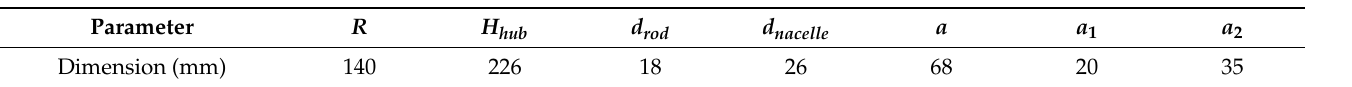
Figure 3. The schematic of the wind turbine model used in the present study. Table 1. The primary design parameters of the wind turbine model used in the present study (for 𝛼 = 5 ° ) .